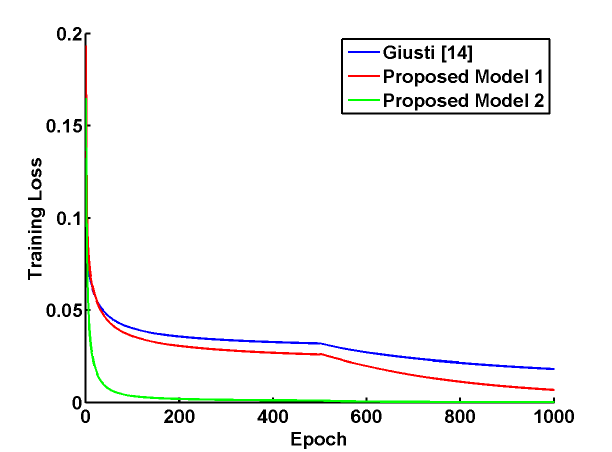
Figure 6. Training losses of competing models with the Adagrad optimizer. The learning rate is decreased by a factor of ten every 500 epochs. Our proposed “Model 2” with “Batch Normalization” achieves the fastest convergence and the lowest training